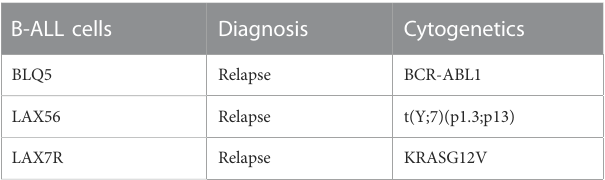
TABLE 1 Patient-derived B-ALL